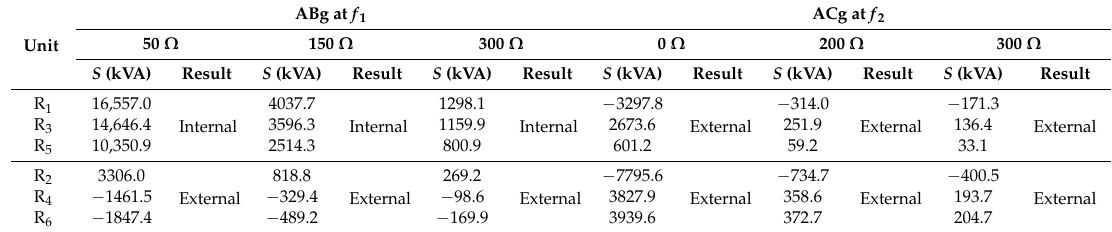
Table 5. Simulation results of the different fault resistances for the busbar I faults and external